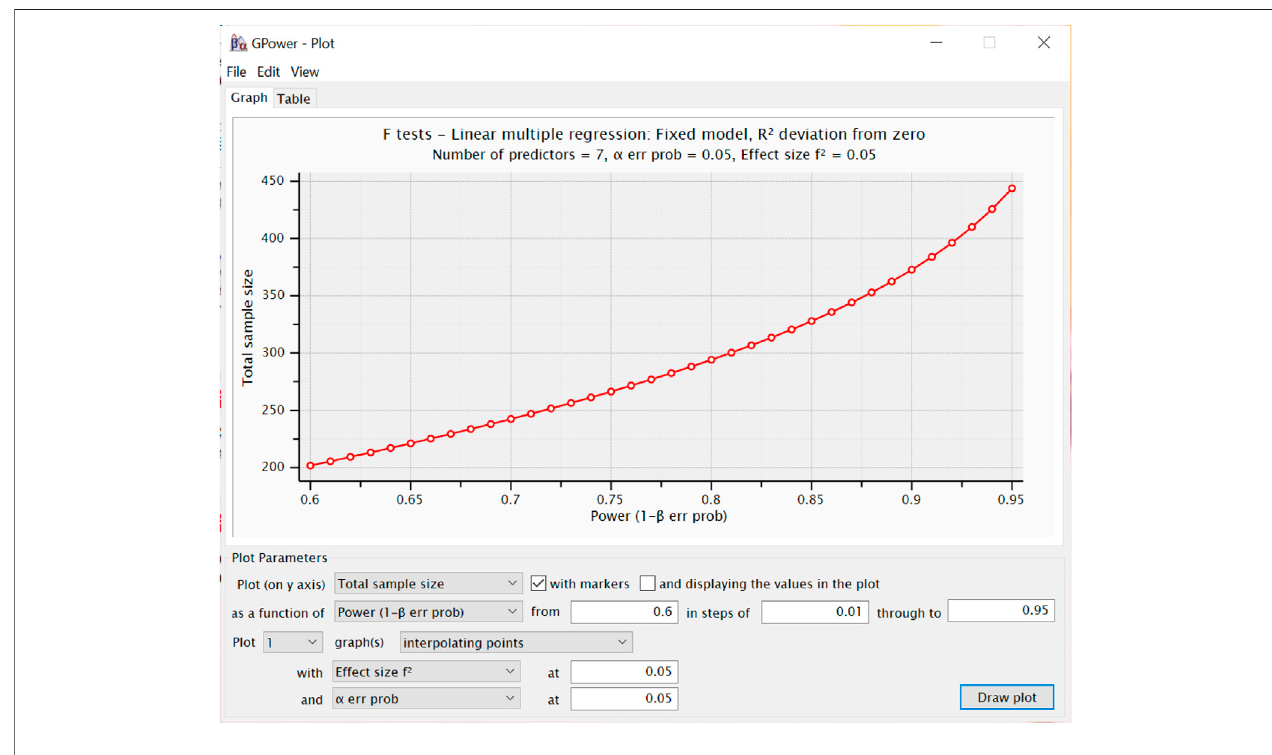
FIGURE 2 | F Tests.